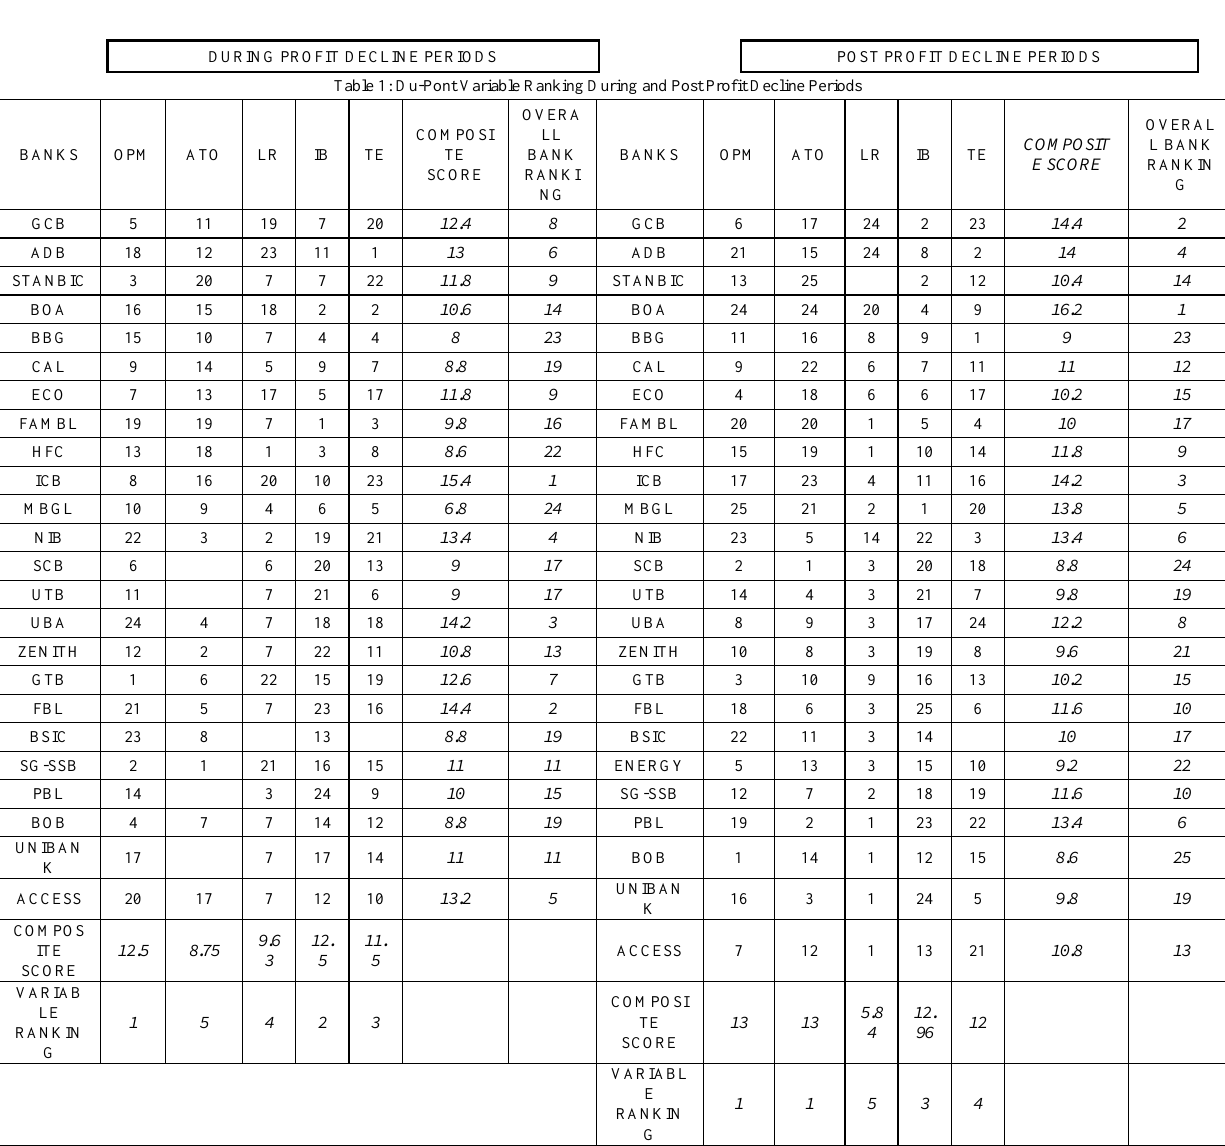
Table 1: Du-Pont Variable Ranking During and Post Profit Decline